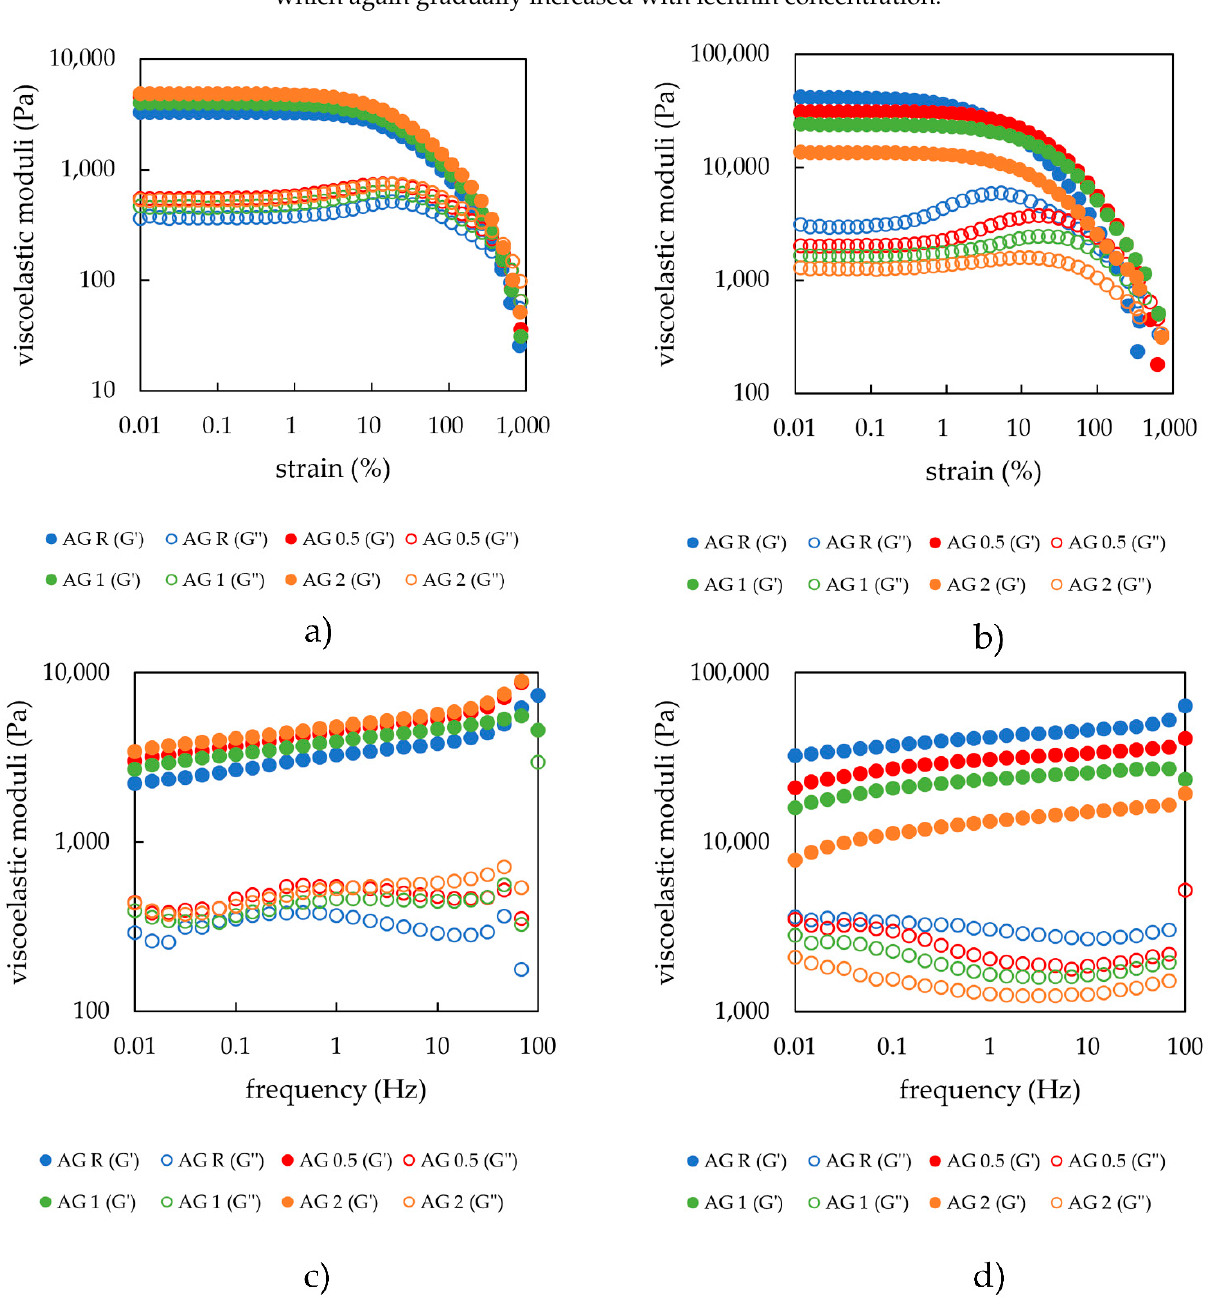
Figure 1. ( a ) Strain sweep of agarose hydrogels with different lecithin concentrations (0, 0.5, 1, and 2 wt.%) after preparation; ( b ) strain sweep of agarose hydrogels with different lecithin concentrations (0, 0.5, 1, and 2 wt.%) after drying and rehydration of the xerogels; ( c ) frequency sweep of agarose hydrogels with different lecithin concentrations (0, 0.5, 1, and 2 wt.%) after preparation; ( d ) frequency sweep of agarose hydrogels with different lecithin concentrations (0, 0.5, 1, and 2 wt.%) after drying and rehydration of the xerogels.